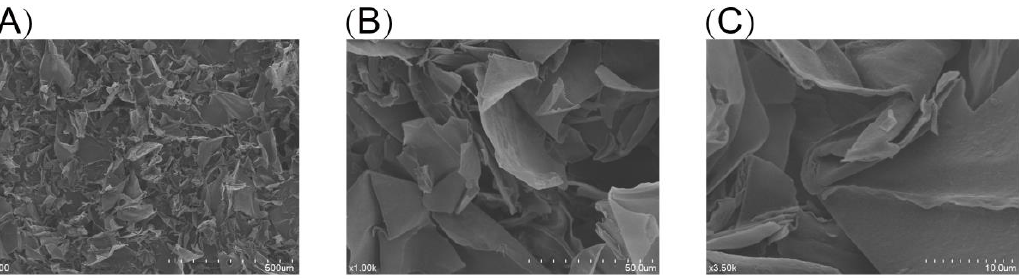
Figure 8. The scanning electron micrographs images of BCP. ( A ) 100 × ; ( B ) 1000 × ; ( C ) 3500 × .